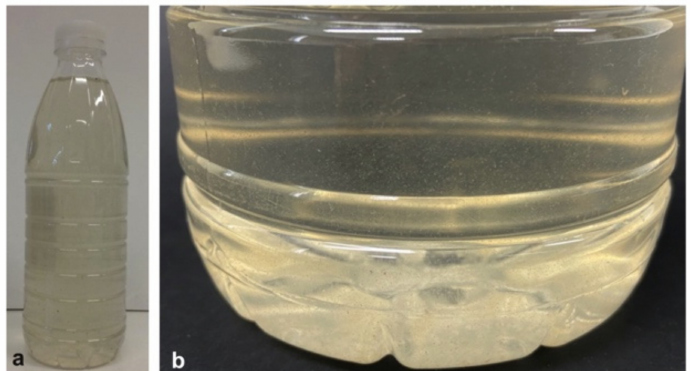
Figure 8. Overall appearance of the UWW used for research. ( a ) Bottle sample with the UWW. ( b ) Detail of the bottom of the bottle with floating clear solid material, after manual shaking.